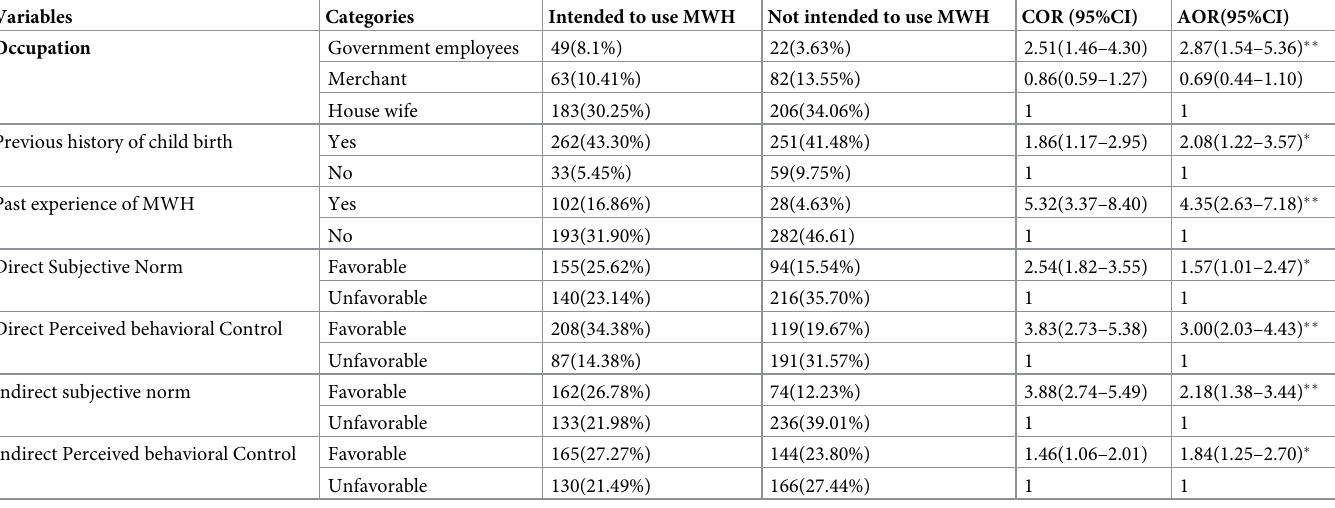
Table 4. Bivariate and multivariate analysis of factors associated with intention to use maternity waiting home among pregnant